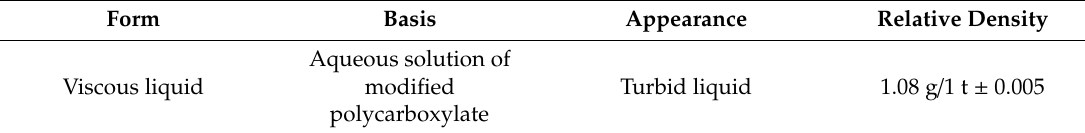
Table 4. Properties of superplasticizer used.